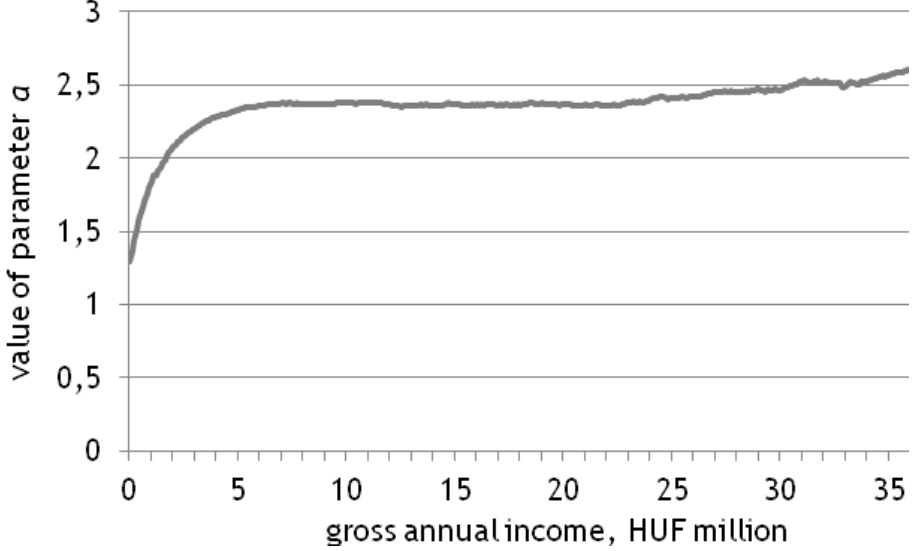
Figure 1. The value of parameter a as a function of the income limit